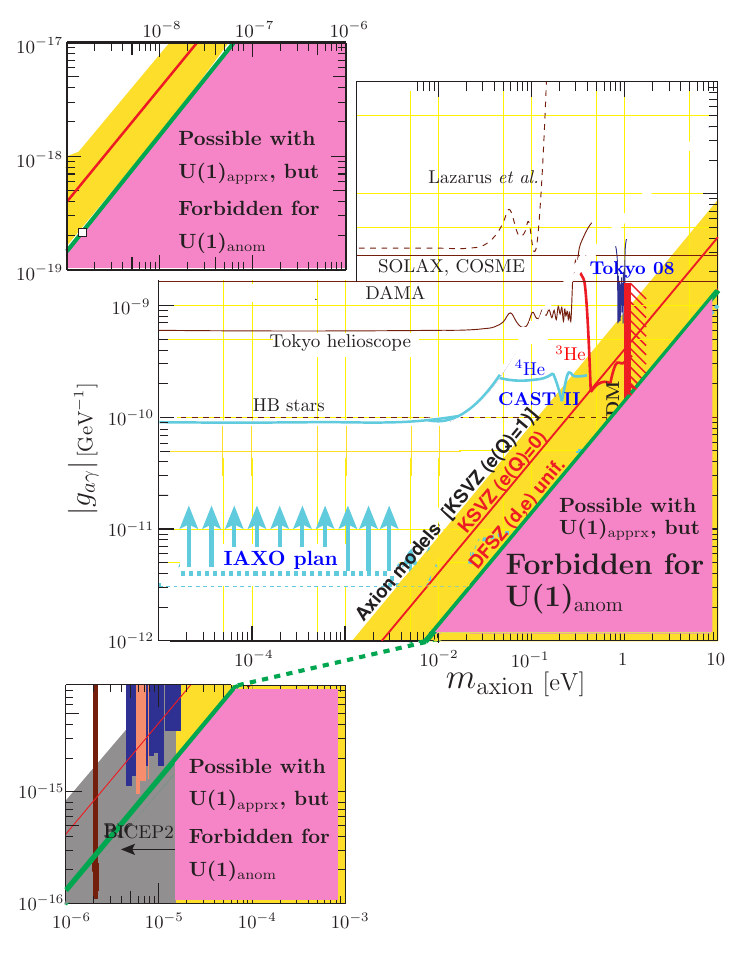
10 − 10 c a γγ ) vs. m a plot [88,89]. ×